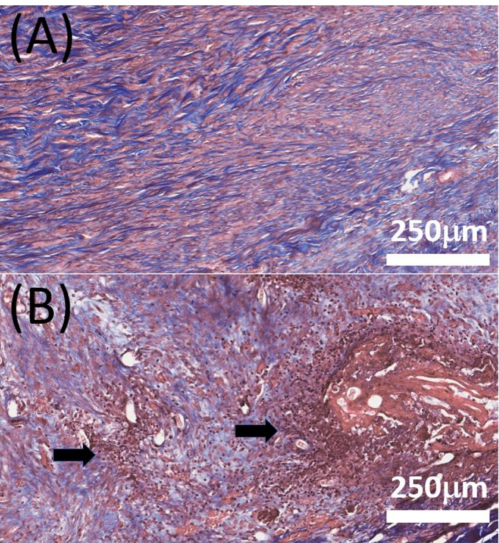
Figure 7. H&E staining of the Achilles tendon at 4 weeks post-surgery. ( A ) Doxycycline group; ( B ) Control (surgery only, no membrane) group. (Magnification: × 160, Pink represents collagen fiber. Arrow: white blood cell accumulation, which indicates inflammation.). Abbreviation: H&E, hematoxylin and